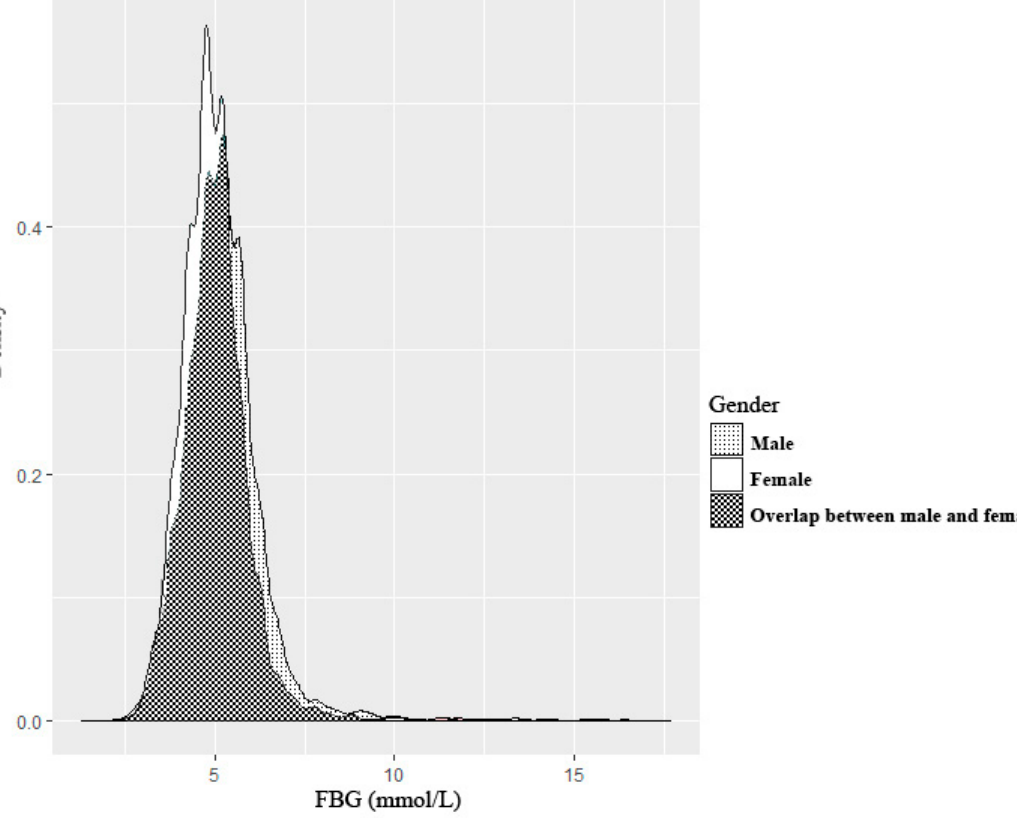
Figure 2. The distribution of FBG for males and females (density diagram).